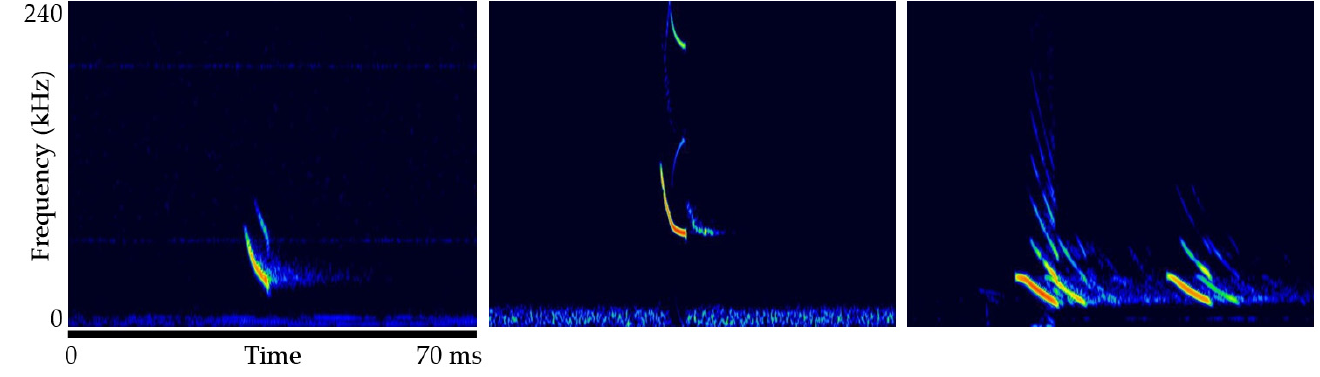
Figure 7. Echolocation calls of FM bat species: M. pilosus ( left ), M. cf. muricola ( center ) and M. plicatus ( right ). Table 1. External measurements (in mm) of captured bats in Son Dong Cave. Abbreviations are defined in the Material and